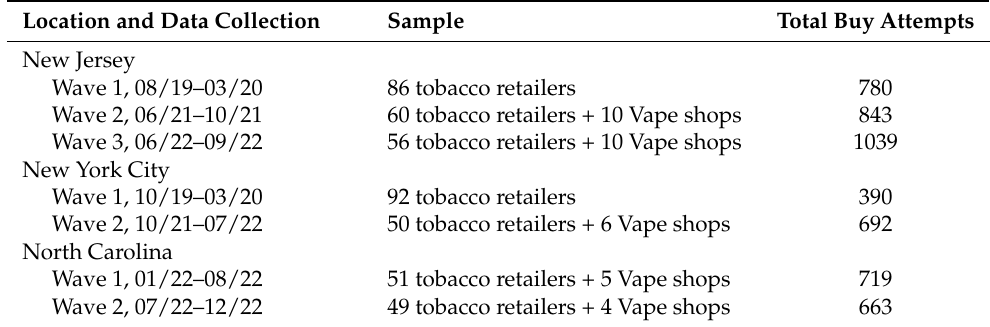
Table 1. Sample Characteristics by Site and Wave,